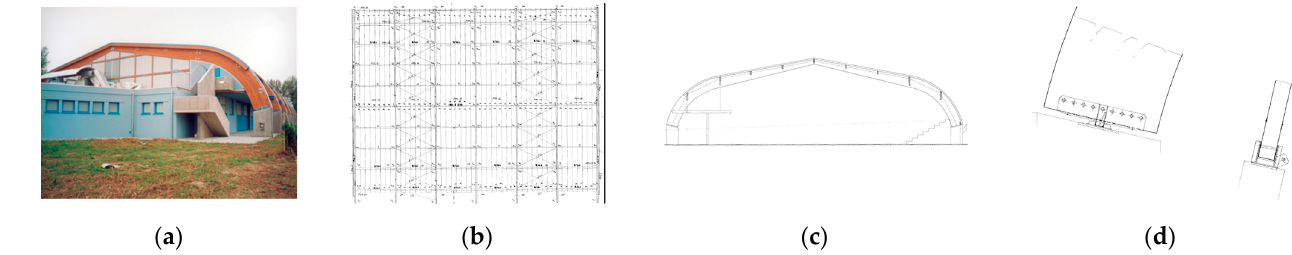
Figure 4. School gym in Mirandola (MO, 1985): ( a ) external view, ( b ) plan view, ( c ) section along main beams, and ( d ) detail of the connection between column and main beam (courtesy of Rubner Holzbau).